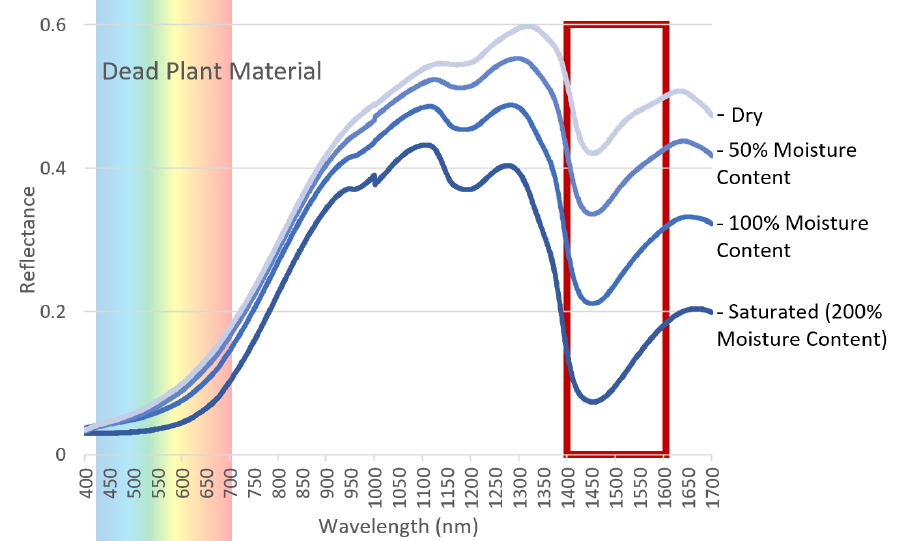
Figure 1. Conceptual diagram of the reflectance of dead vegetation when it is fully saturated with water to when it is dry. The red box is the section of the NIR electromagnetic spectrum that has the greatest change as vegetation dries (1400 – 1600 nm).